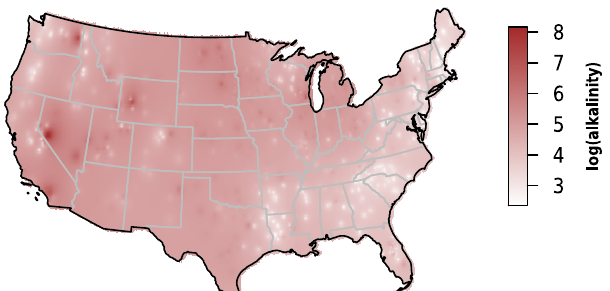
Figure 2. Map of log-scaled alkalinity (mgL − 1 ) interpolated using inverse distance weighting.